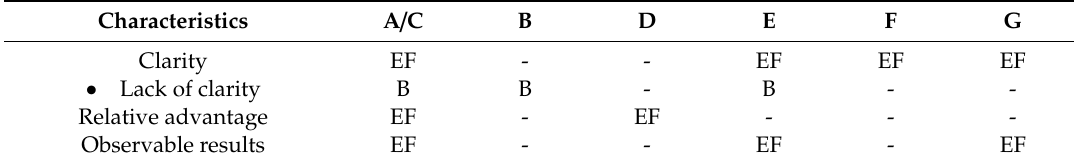
Table 2. Innovation construct characteristics and whether they were enabling factors (EF) and / or barriers (B) to the implementation of HealthWISE in each participating hospital (A–G).